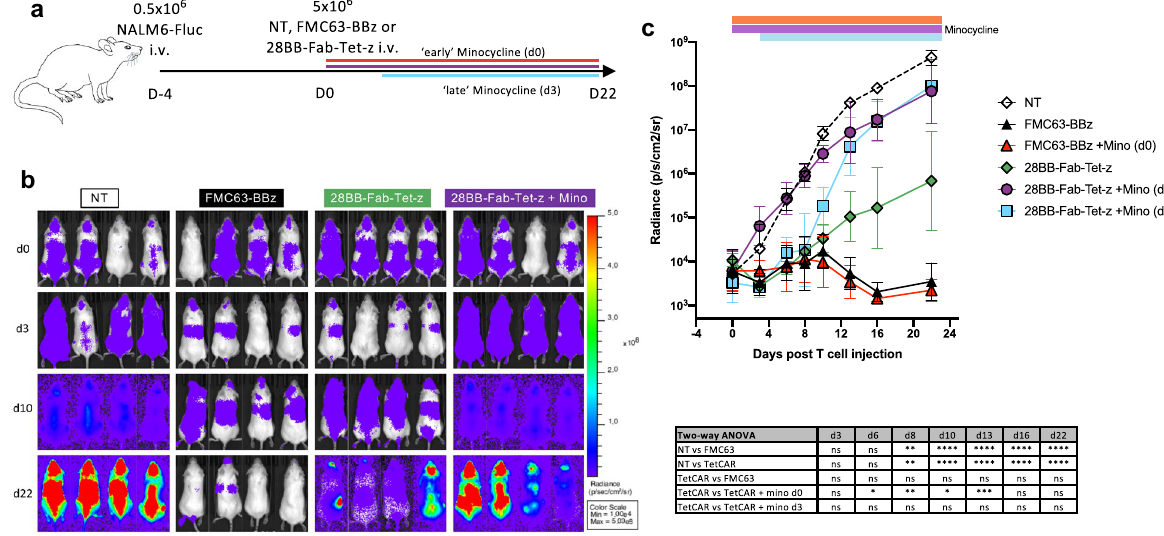
Figure 6. 28BB-Fab-Tet-z function and inhibition in vivo. ( a ) Overview of in vivo experiment. NSG mice were injected i.v. with 0.5 × 10 6 NALM6-FLuc tumor cells. On day 0, mice were randomly assigned based on tumor burden to receive 5 × 10 6 non-transduced (NT), FMC63-BBz or 28BB-Fab-Tet-z CAR T cells. Groups were further divided with some to receive 0.4 mg minocycline i.p. every 1–2 days, starting either on day 0 or day 3. ( b ) Bioluminescence radiance (photons/s/cm 2 /sr) of NALM6-FLuc tumors in mice in select groups. ( c ) Geometric mean radiance (photons/s/cm 2 /sr) of NALM6-FLuc cells, in mice in all groups treated with NT, FMC63-BBz (± minocycline) or 28BB-Fab-Tet-z CAR T cells (± minocycline). n = 4 mice per group from 1 experiment. Table shows statistical analysis through one-way ANOVA with multiple comparisons between groups at each time